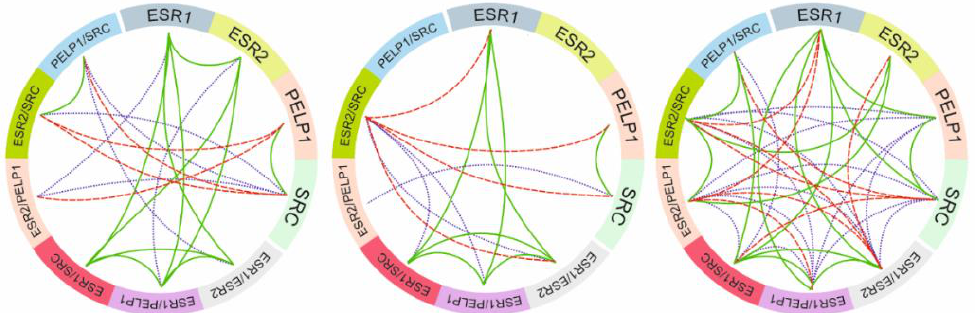
Figure 4. Circular correlation coefficient plot of gene expression and expression quotient. Reverse proportional correlations were indicated by red dash lines, proportional correlation by solid green lines and violet dotted lines indicated significant correlation coefficients relationship in gene-to-gene expression and quotient-to-quotient influence. Ovary without changes (left), benign noncancerous tissue samples (middle), and ovarian cancer (right).